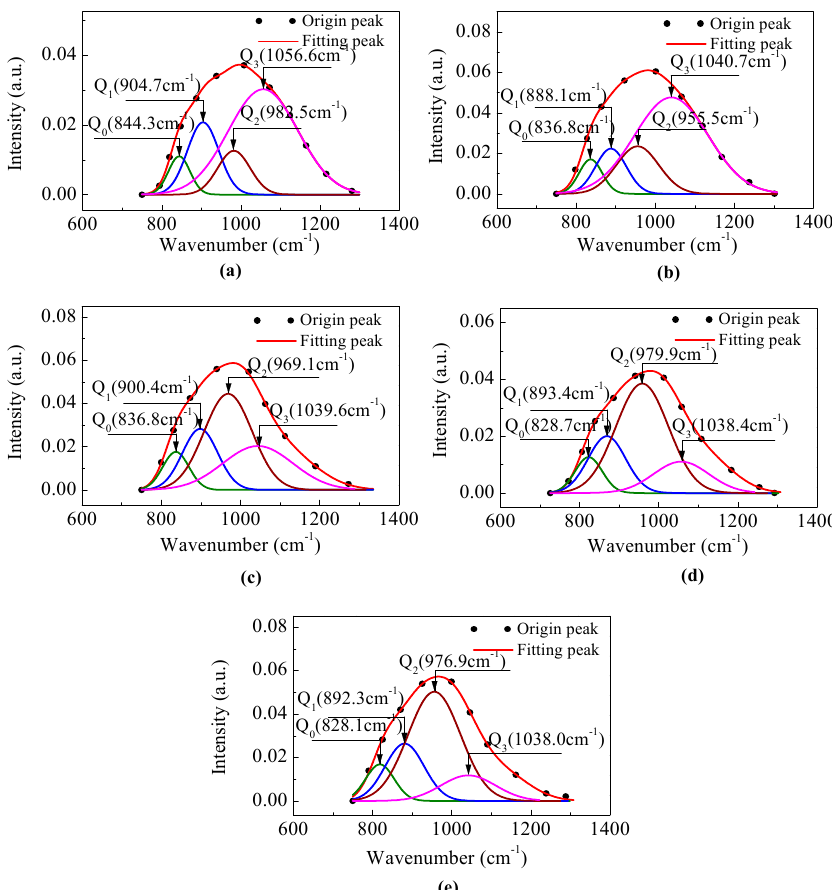
Figure 3. Deconvolution results of the FTIR curves with the various R 2 , and ( a ) the R 2 is 0.9, ( b ) the R 2 is 1.0, ( c ) the R 2 is 1.1, ( d ) the R 2 is 1.2, ( e ) the R 2 is 1.3. The relative area of each peak corresponding to each structural unit Q n ( n = 0, 1, 2, 3) was calculated according to the peak division results. Then, the curve of the relative con- R 2 increased from 0.9 to 1.3, the relative content of Q 0 and Q 1 gradually increased but the range of change was not large, from 7.0% to 10.0% and from 19.2% to 21.4%, respectively, while the relative content of Q 3 decreased significantly from 61.8% to 13.4% and the